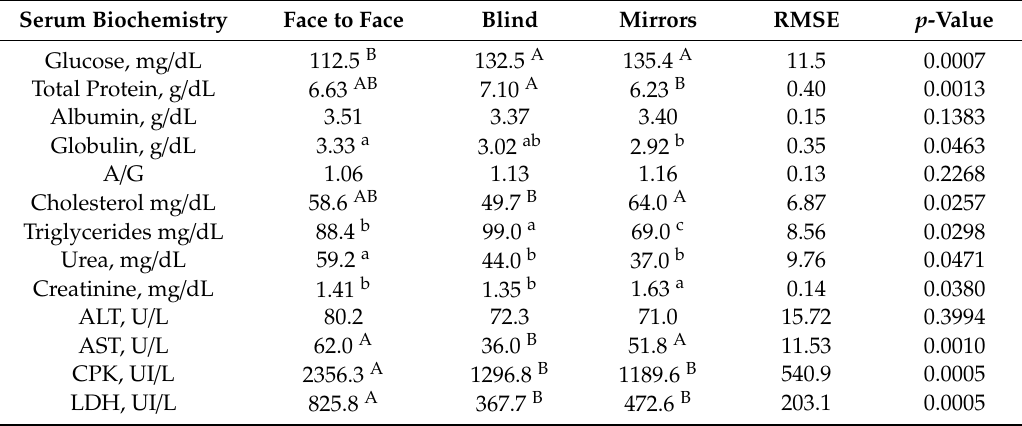
Table 8. Serum biochemistry of rabbits according to the housing systems. Serum Biochemistry Face to